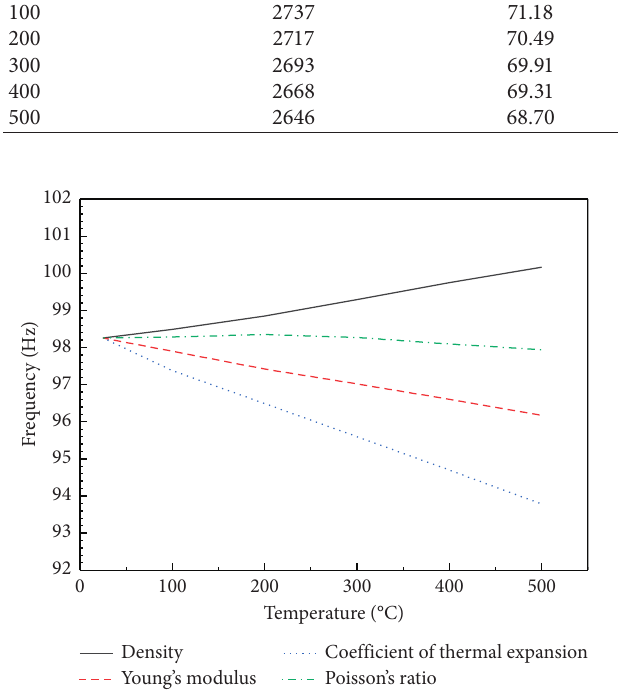
Figure 2: First-order natural frequency univariate analysis.